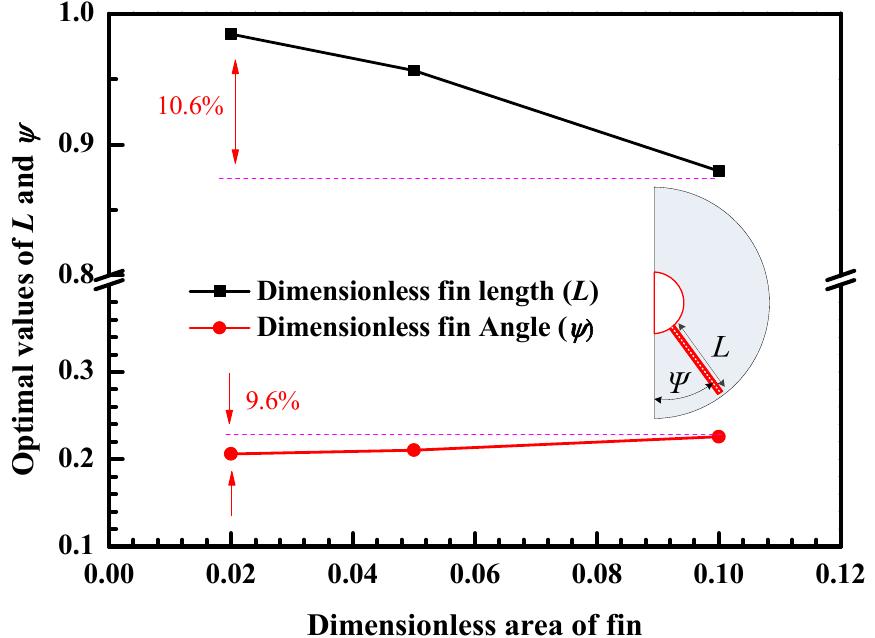
Figure 12. Variation of the optimal dimensionless fin length, L , and dimensionless fin angle, ψ , with the dimensionless fin area, A .